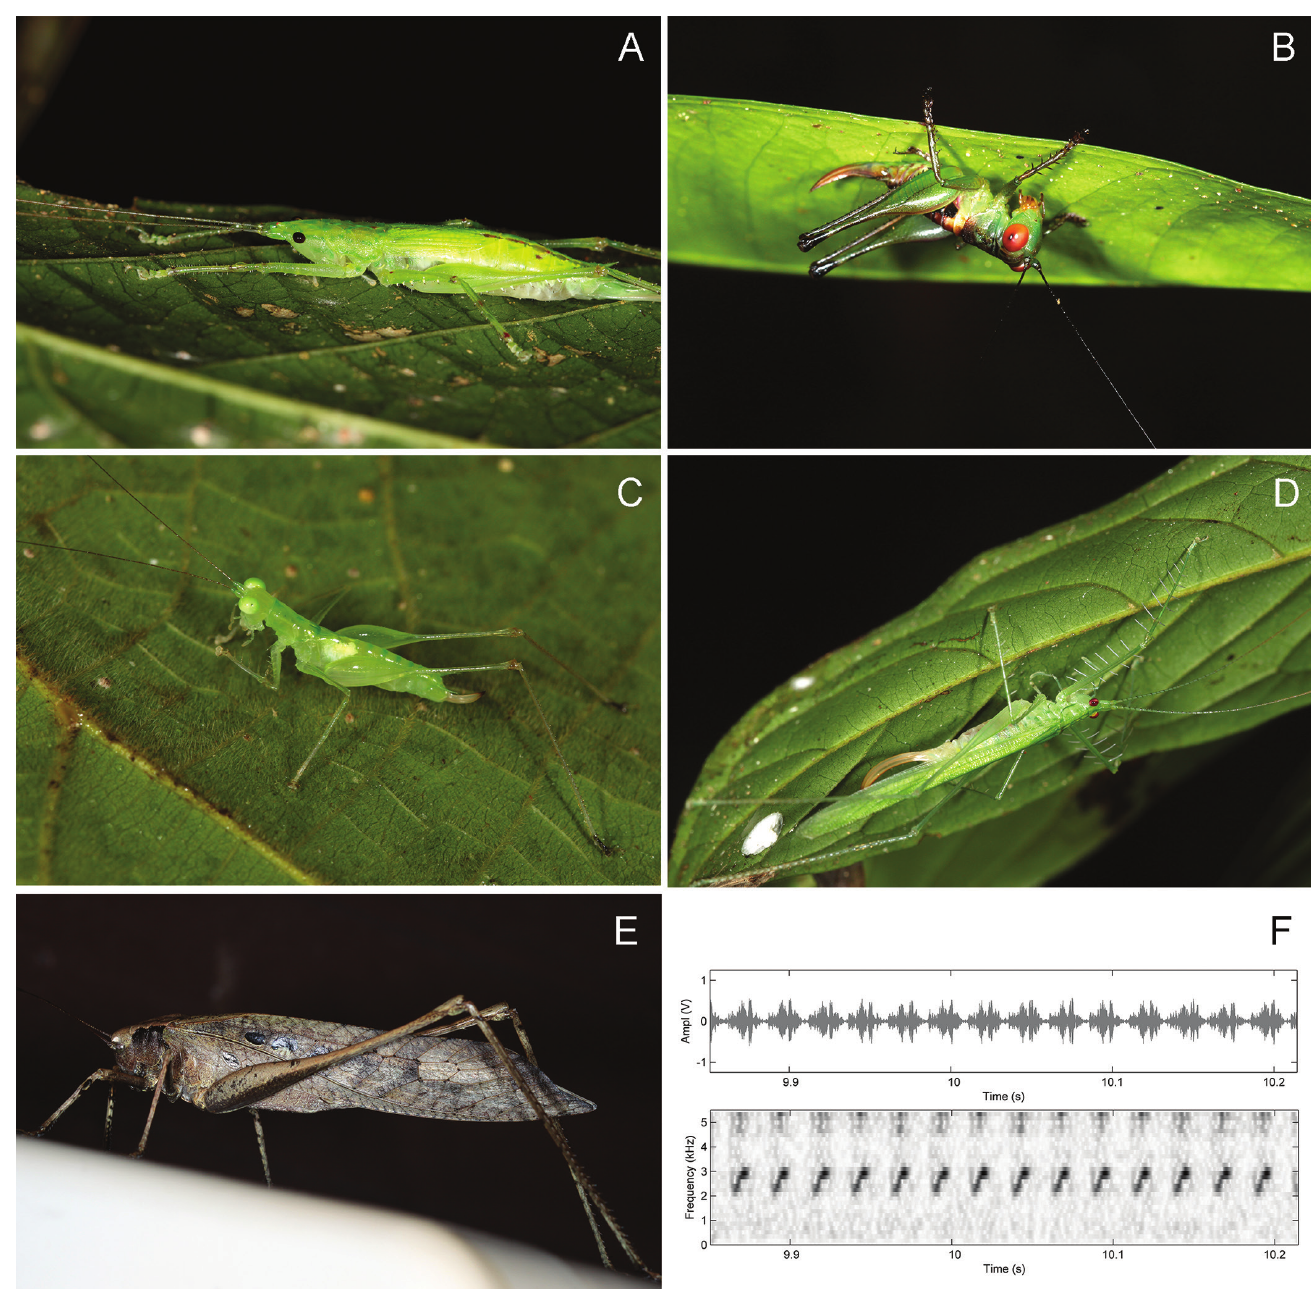
Fig. 15. Tettigoniidae: A. Viriacca modesta ; B. Lipotactes alienus ; C. Asiophlugis longiuncus ; D. Neophisis ( Indophisis ) cf. longipennis or curvata ; Mecopoda elongata : E. Female; F. Calling